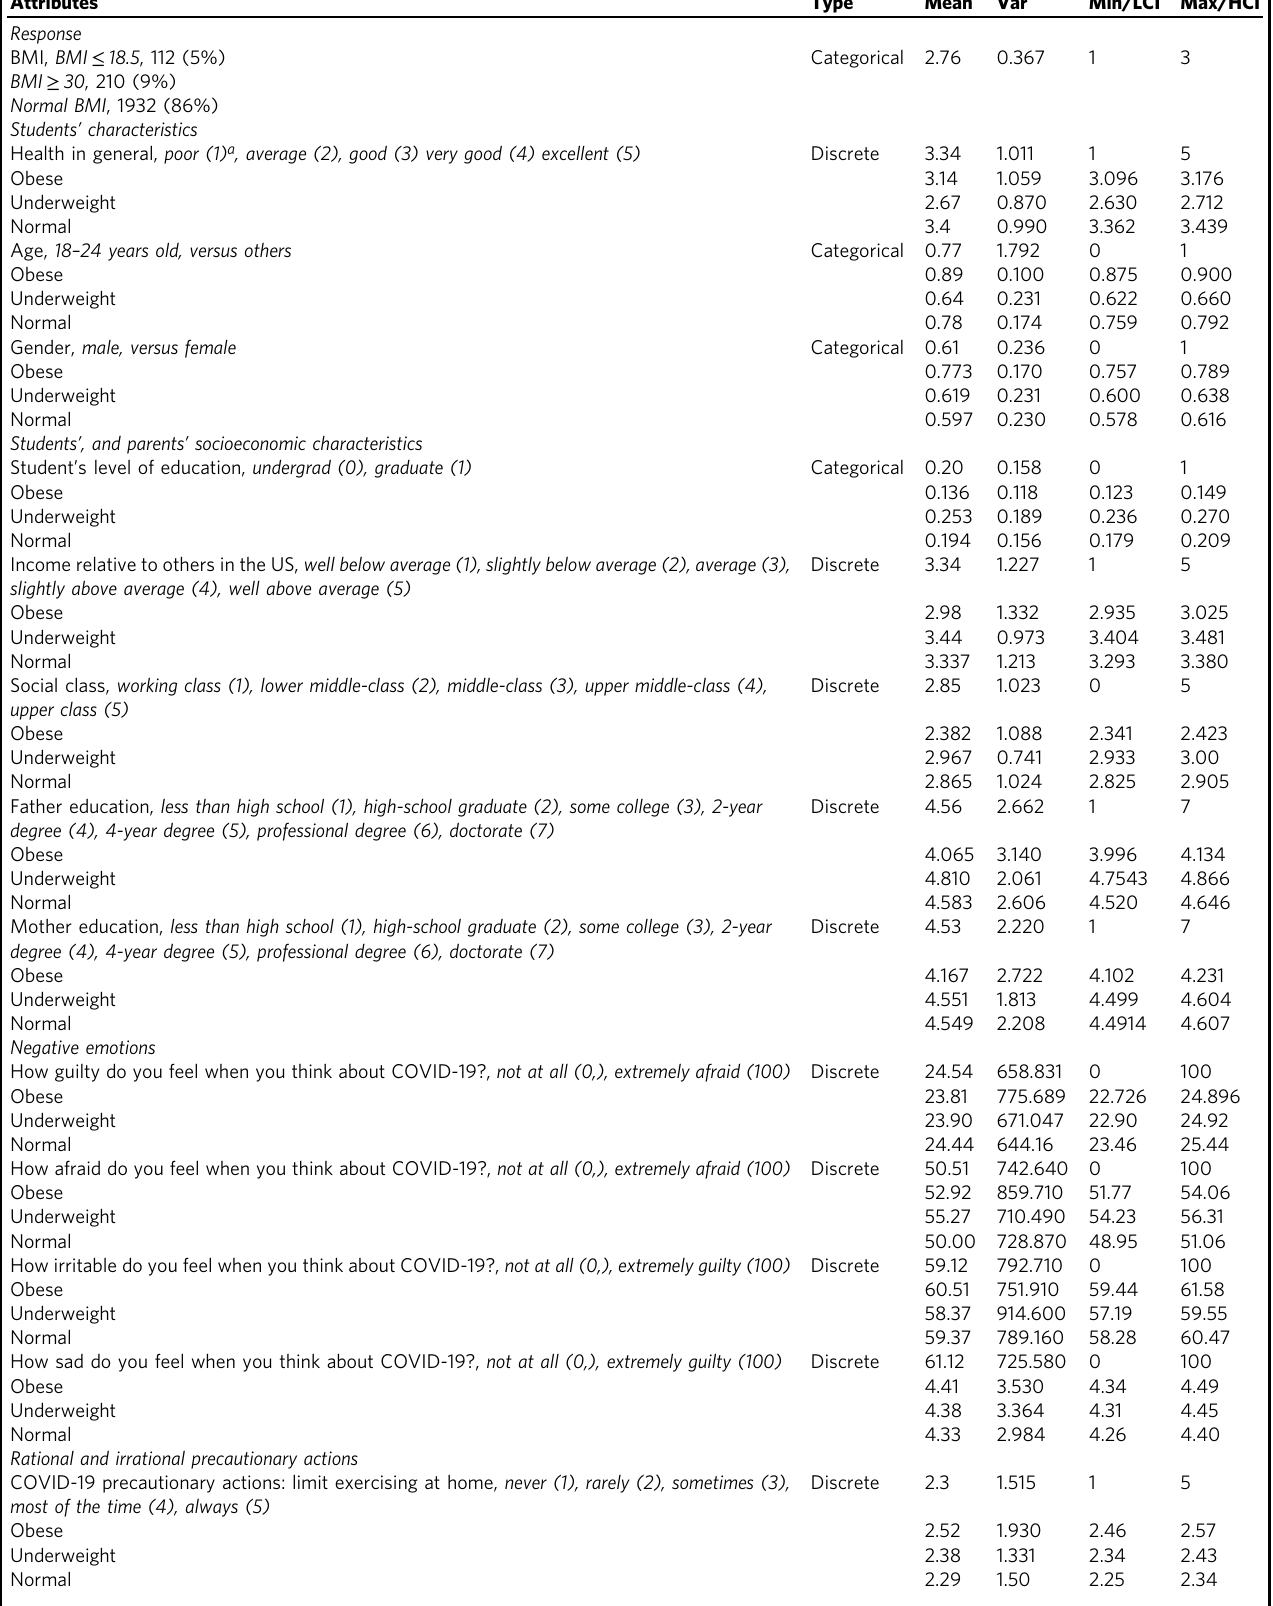
Table 1 Descriptive summary of signi fi cant predictors in the